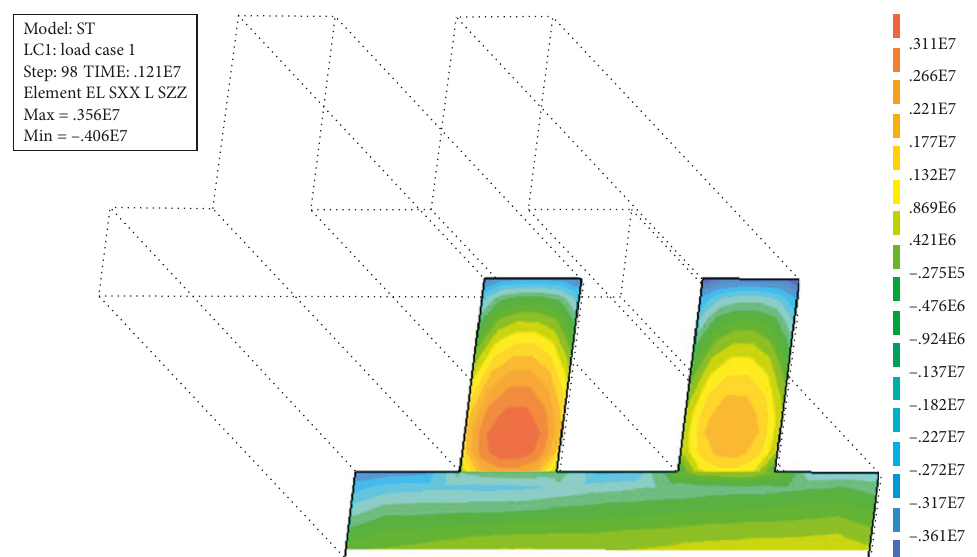
Figure 14: Stress contour in the middle section of